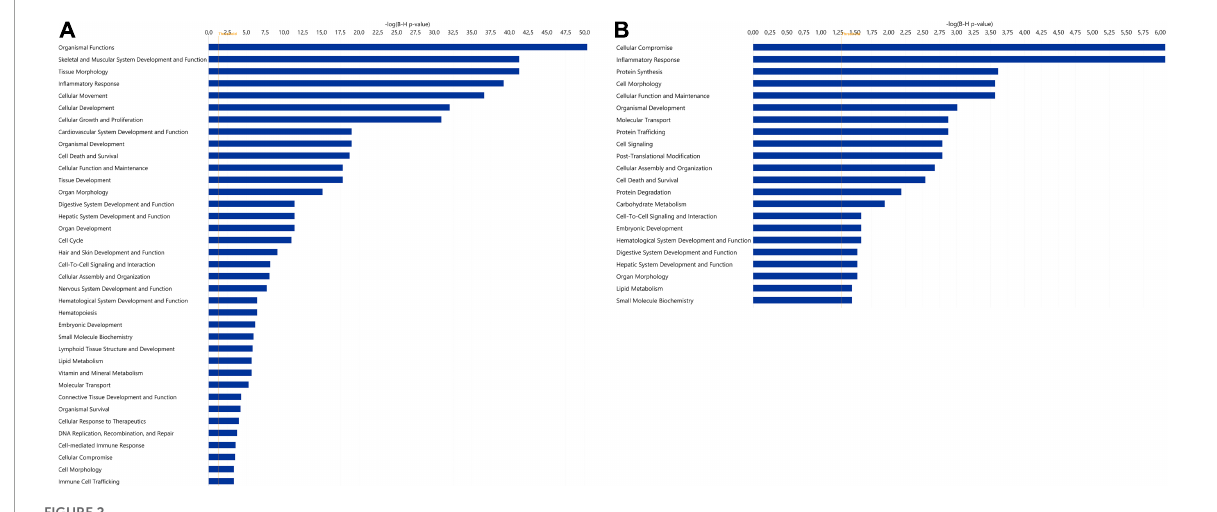
FIGURE2 Significantly enriched functions for (A) the 123 highly expressed miRNAs and (B) the 346 highly expressed proteins in human term healthy placentas. Data presented as –log ( p -value), p = 0.05. For both analyses, diseases and disorders have been excluded. In panel A , the function “gene silencing/gene expression” is not shown but, as expected, it was the most prominent